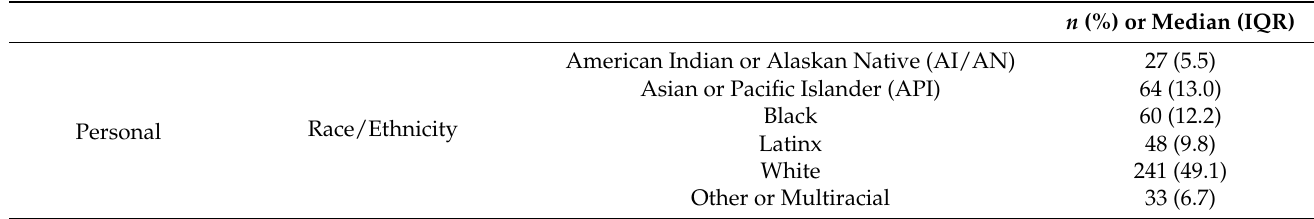
Table 1. Characteristics of women enrolled in The COPE